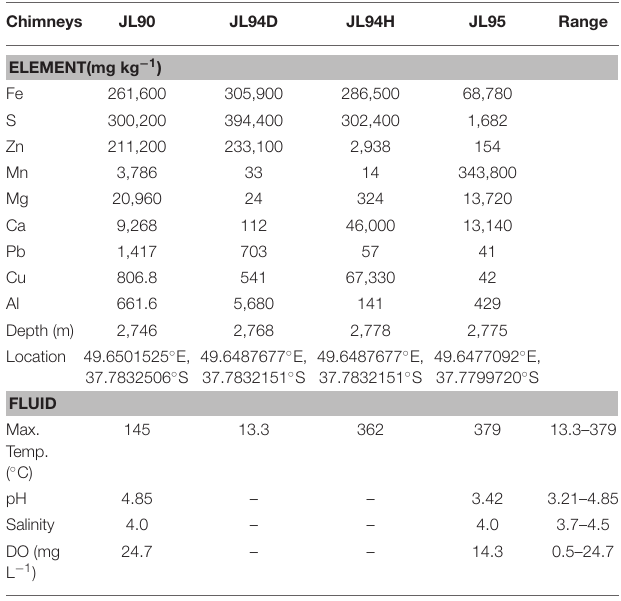
TABLE 1 | Concentrations of Elements in chimney deposits and physicochemical characteristics of their hydrothermal fluids at the Longqi field on